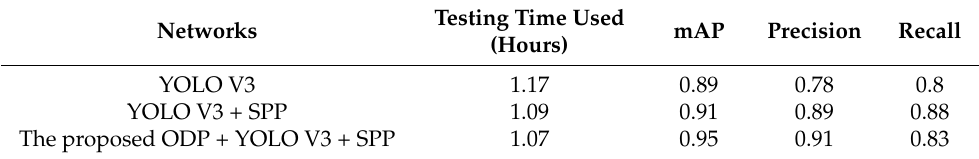
Table 3. Comparison of evaluation indicators on YOLO Network performance.